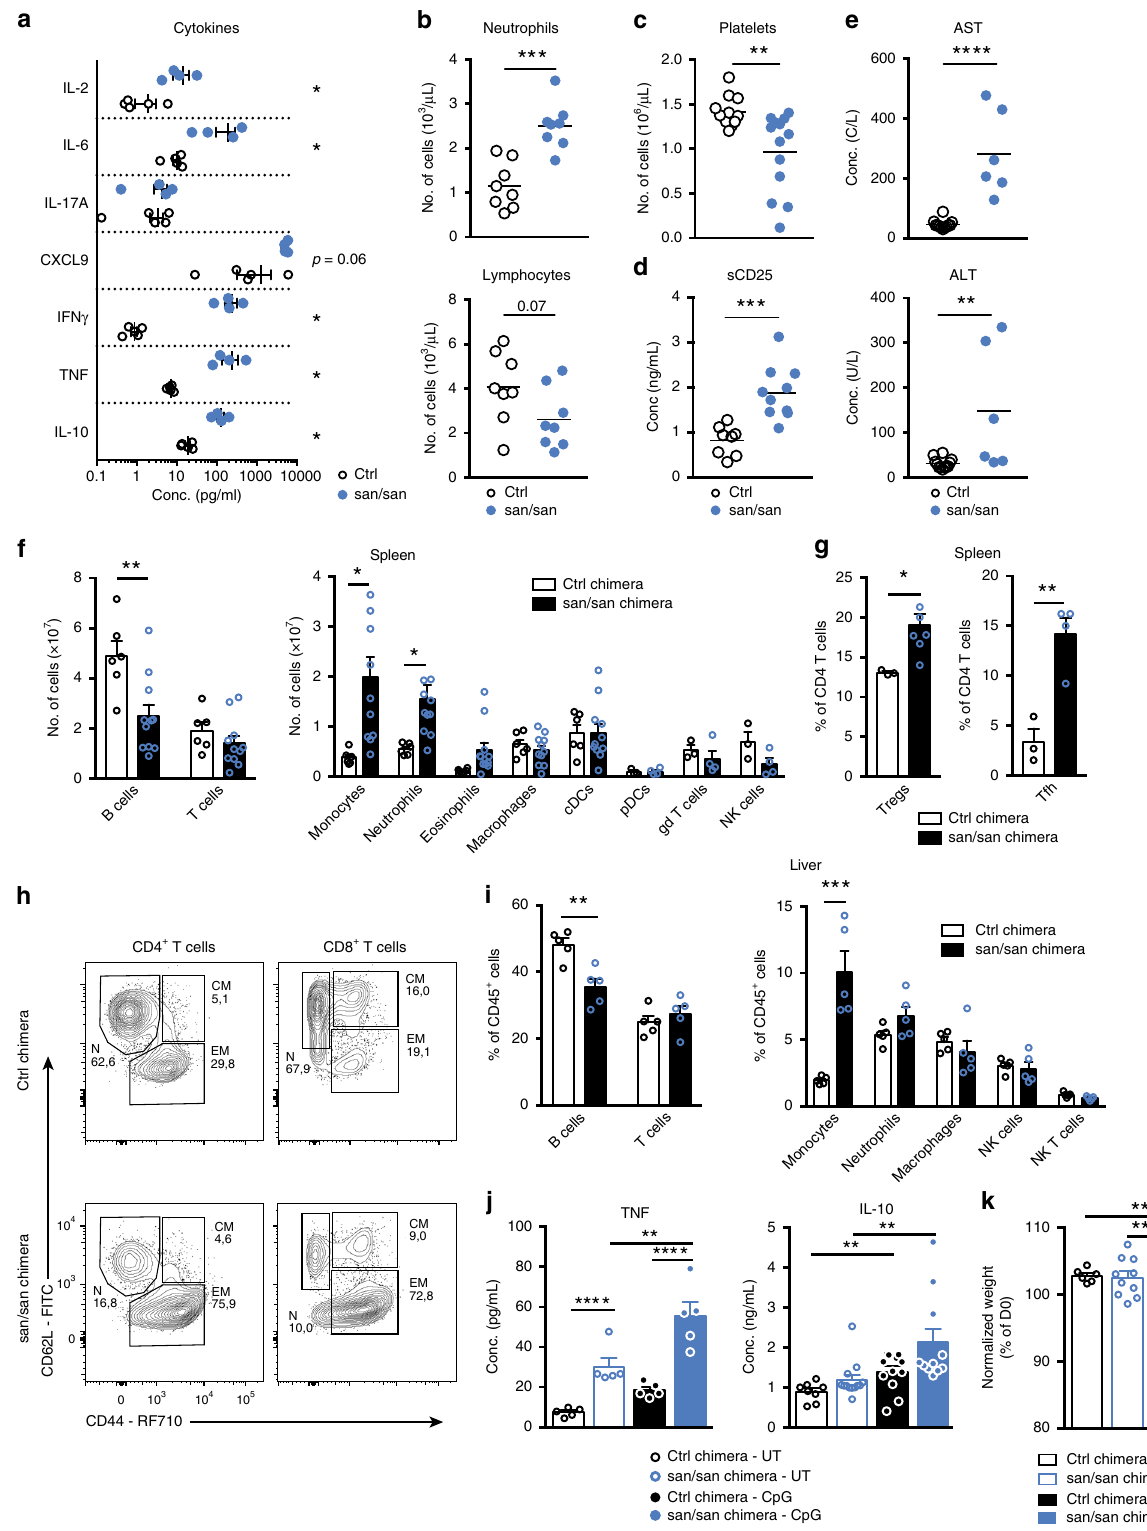
treatment of myelo fi brosis and polycythemia vera in JAK2 gain of function mutations. It inhibits a number of cytokines such as IL- 1, IL-6, IL-18, IFN γ , and TNF and reduces pathology in models of HLH 39,40 . The potential of ruxolitinib for HLH treatment has been suggested in a case study of refractory HLH 41 and is under evaluation in clinical trials (NCT03533790 and